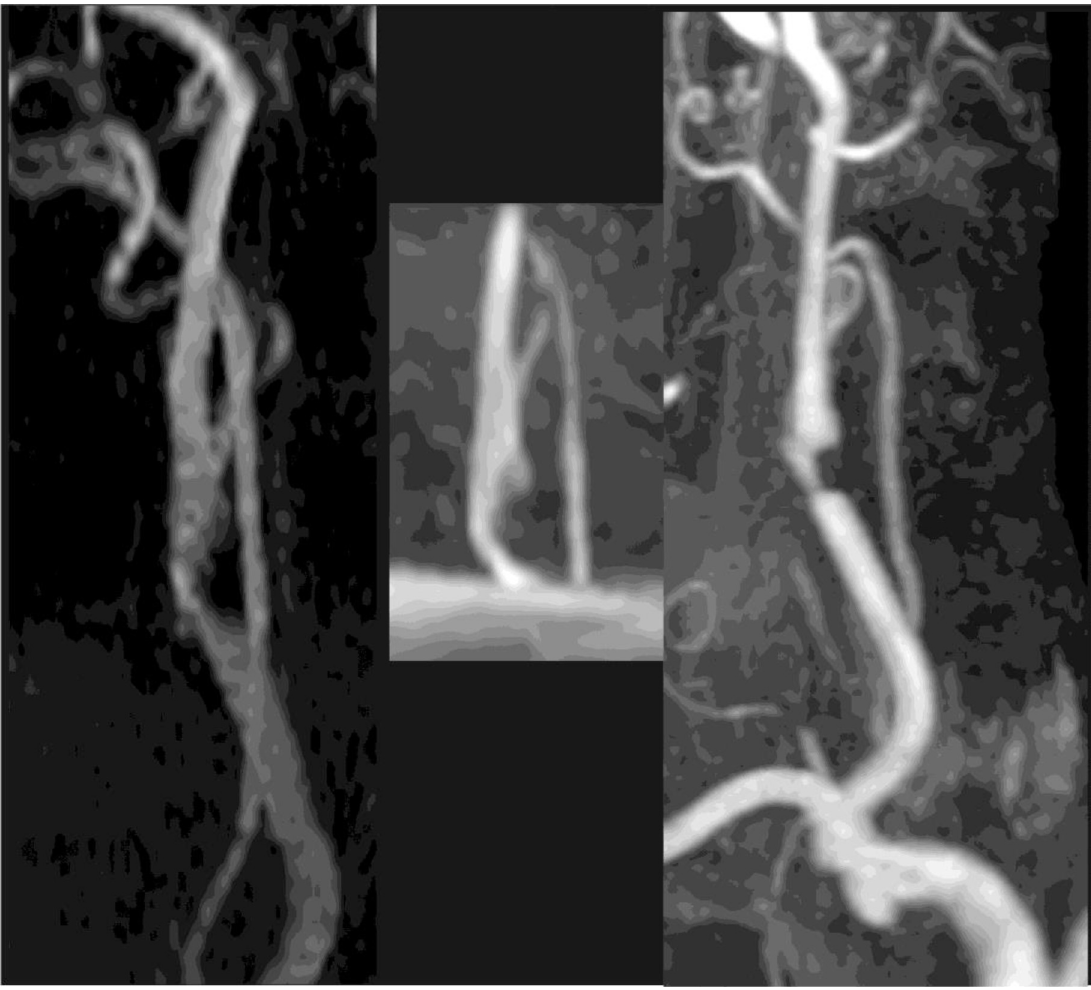
Fig 2. MRA images chosen to show variability of 3D TOF undercalling stenosis relative to CE-MRA and 2D TOF MRA. Variability of interpretation of 2D (left), 3D (middle) and CE-MRA (right) for patient 9. Scores for the 6 readers were: 2D- 3,3,1,1,4,3 (average 2.5); 3D- 1,1,1,1,2,2 (1.3); CE- 2,3,2,1,5,3 (2.7) where 1 = 0–30% stenosis, 2 = 31–50%, 3 = 51–70, 4 = > 70%, 5 = near occlusion, 6 = occluded. Average quality ratings were 2DTOF = 2.6, 3DTOF = 3.8, CEMRA =